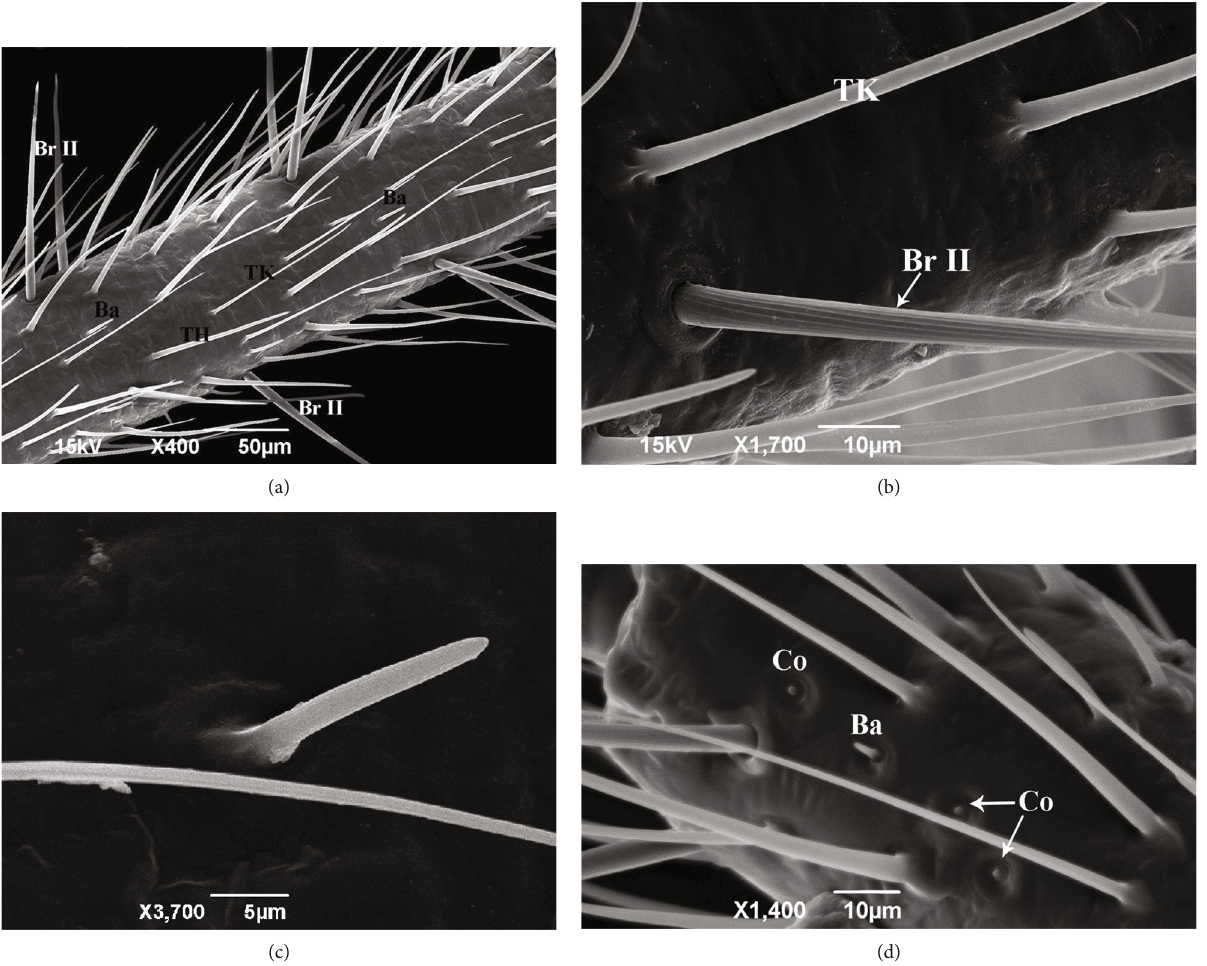
Figure 3: Scanning electron micrographs of the third antennal segment (S3) of R. brethesi. (a) Br II: bristles II; Ba: basiconica sensilla; TH: thin-walled trichoidea sensilla; TK: thick-walled trichoidea sensilla. (b) Bristles II (Br II) detail. TK: thick-walled trichoidea sensilla. (c) Basiconica sensilla. (d) Ba: basiconica sensilla; Co: coeloconica. Table 1: Characterization of each type of antennal sensilla according to the antennal segment in Rhodnius brethesi